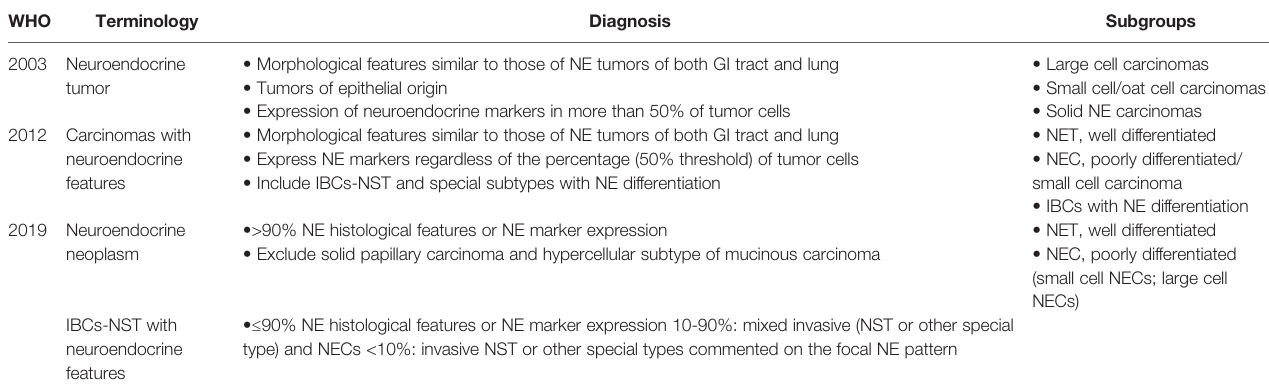
TABLE 1 | Summary of different WHO classi fi